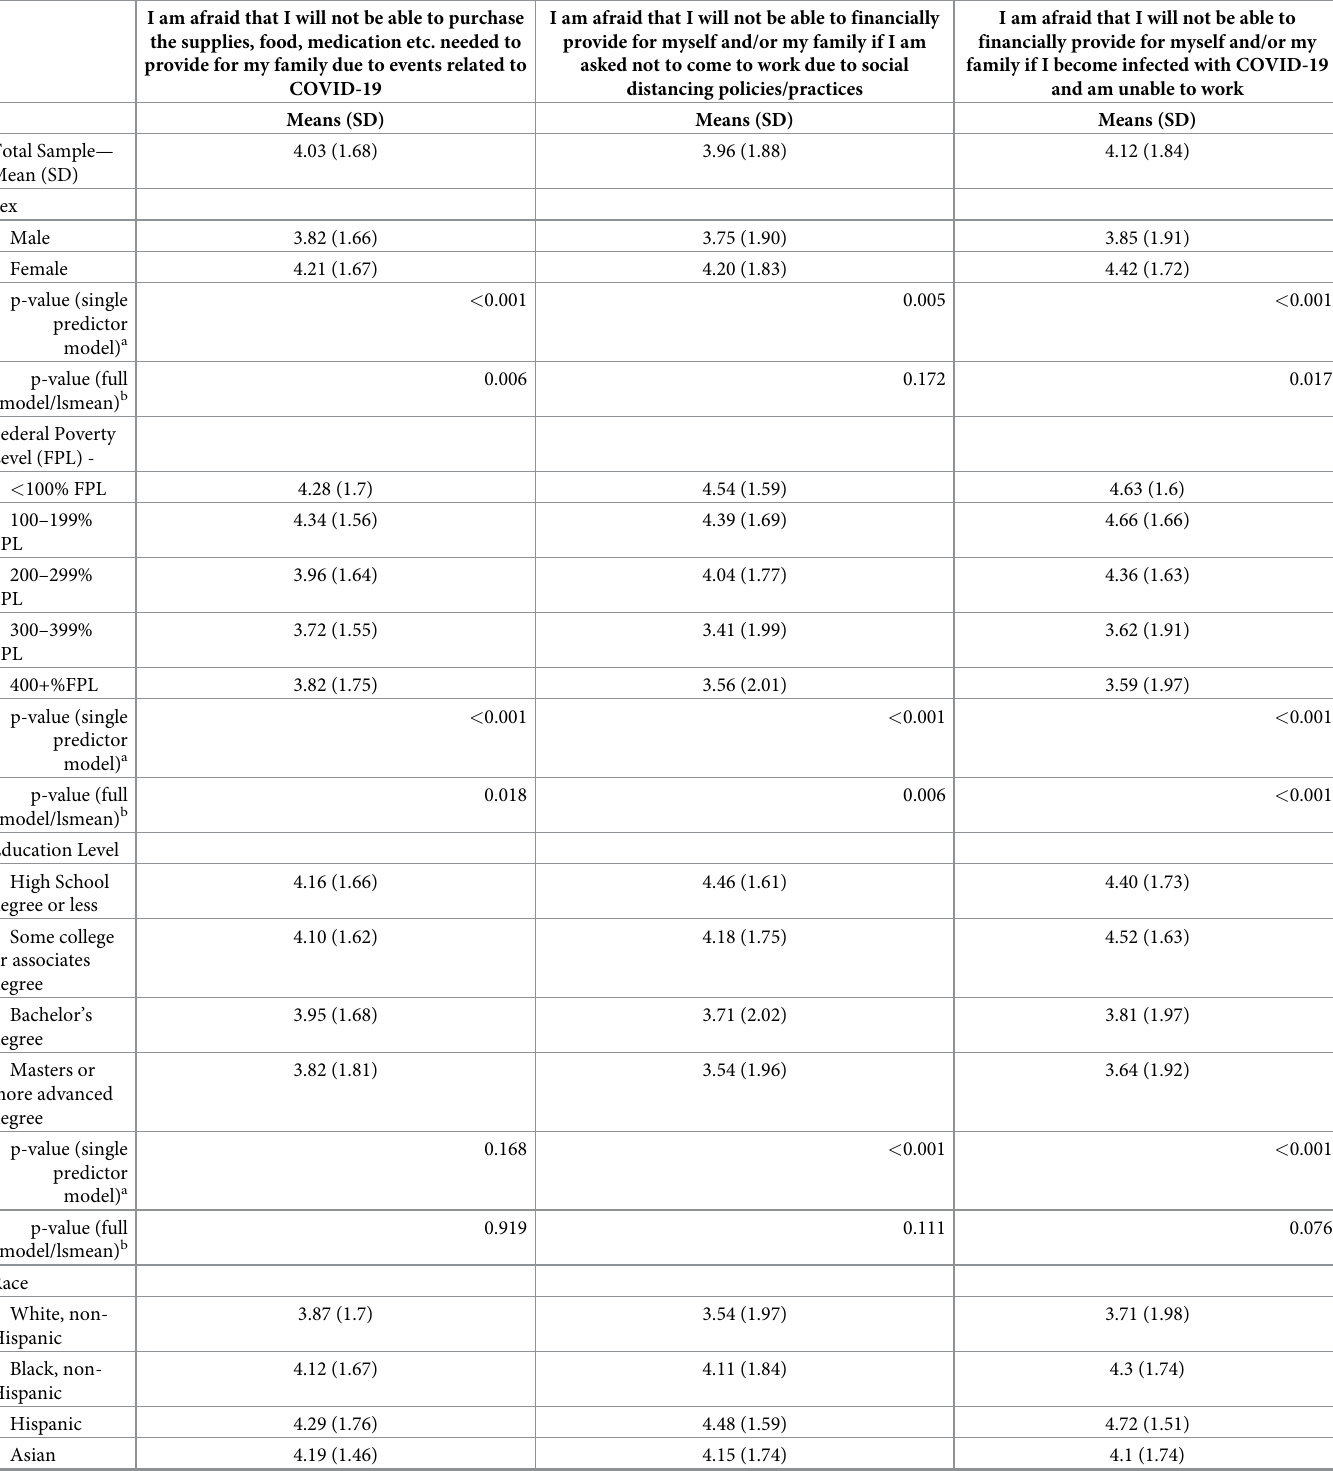
Table 3. Economic anxieties related to COVID-19 by demographic